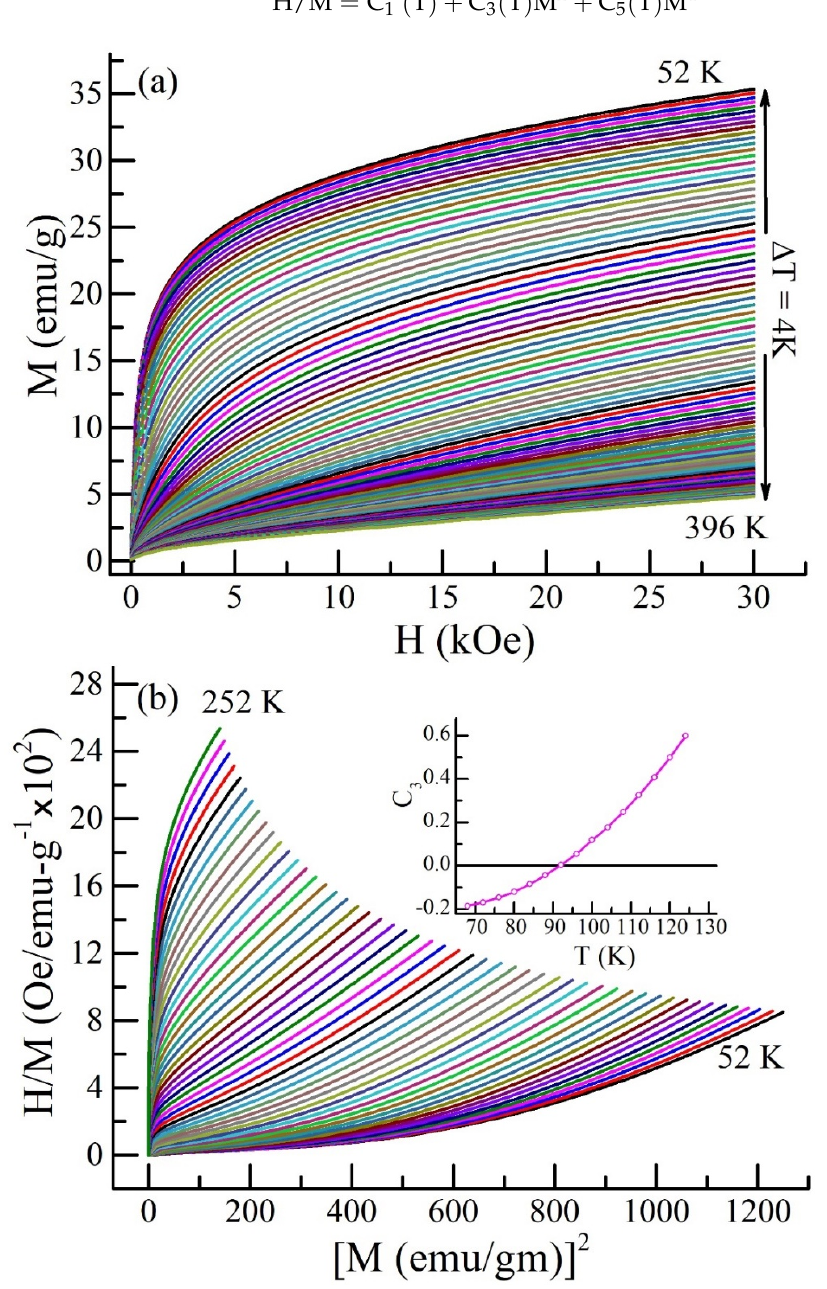
Figure 3. ( a ) Virgin isothermal magnetization curve at different temperatures for Fe 65 Ni 35 . ( b ) Arrott plot, derived from virgin magnetic isotherms, at different temperatures for Fe 65 Ni 35 . Inset : C 3 vs. T plot (obtained from the non-linear curve fitting by using Equation (2)) for Fe 65 Ni 35 . The coefficient C 3 determines the order of phase transition; it has a positive or negative value for the second-order and first-order, respectively [15]. We have calculated the value C 3 from the H/M vs. M 2 plot fitted in Equation (2). The calculated values were plotted as a function of temperature (shown in Inset of Figure 3b). The curve shows a positive value above 88 K; below this, it changes its sign and converts into a negative value.